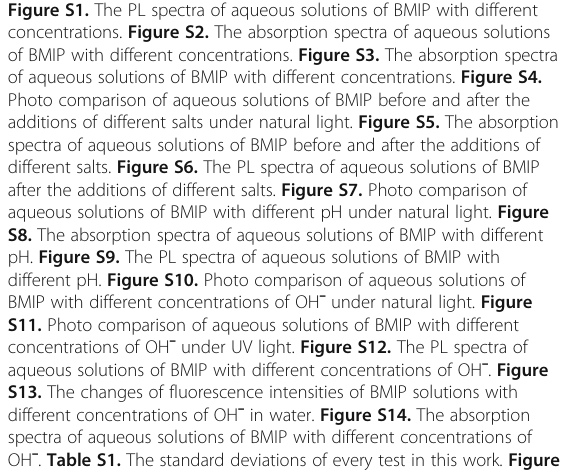
Figure S1. The PL spectra of aqueous solutions of BMIP with different concentrations. Figure S2. The absorption spectra of aqueous solutions of BMIP with different concentrations. Figure S3. The absorption spectra of aqueous solutions of BMIP with different concentrations. Figure S4. Photo comparison of aqueous solutions of BMIP before and after the additions of different salts under natural light. Figure S5. The absorption spectra of aqueous solutions of BMIP before and after the additions of different salts. Figure S6. The PL spectra of aqueous solutions of BMIP after the additions of different salts. Figure S7. Photo comparison of aqueous solutions of BMIP with different pH under natural light. Figure S8. The absorption spectra of aqueous solutions of BMIP with different pH. Figure S9. The PL spectra of aqueous solutions of BMIP with different pH. Figure S10. Photo comparison of aqueous solutions of BMIP with different concentrations of OH ˉ under natural light. Figure S11. Photo comparison of aqueous solutions of BMIP with different concentrations of OH ˉ under UV light. Figure S12. The PL spectra of aqueous solutions of BMIP with different concentrations of OH ˉ . Figure S13. The changes of fluorescence intensities of BMIP solutions with different concentrations of OH ˉ in water. Figure S14. The absorption spectra of aqueous solutions of BMIP with different concentrations of OH ˉ . Table S1. The standard deviations of every test in this work.